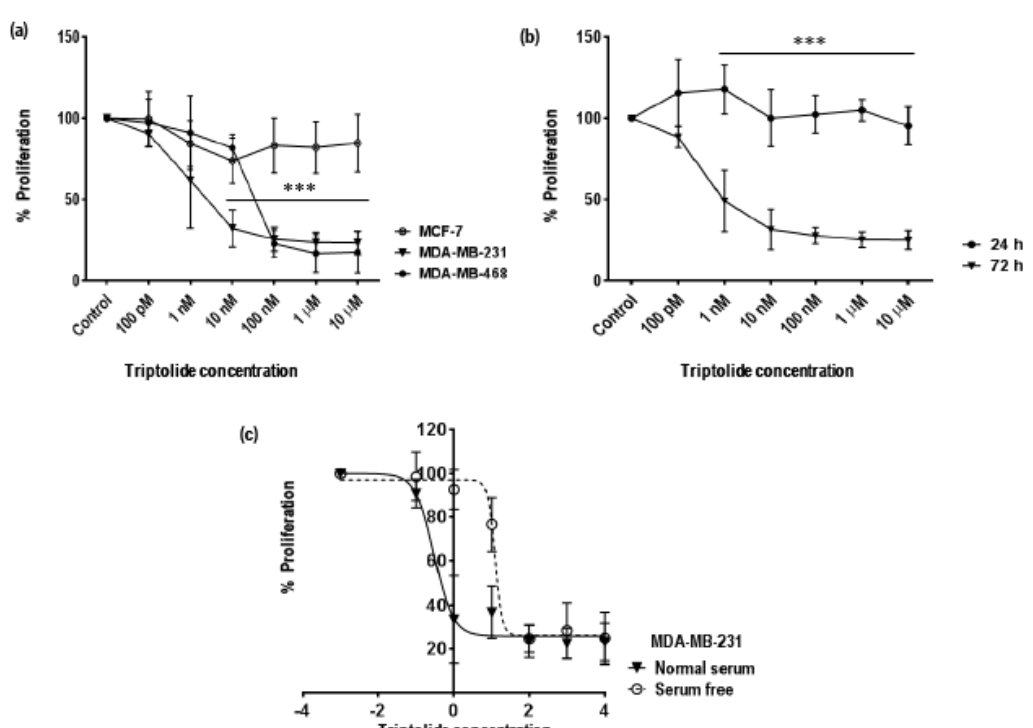
Figure 1. Effect of triptolide on cell proliferation in MDA-MB-231 cells. The line graph illustrates the effect of varying concentration of triptolide (100 pM to 10 µM) on cell proliferation ( a ) in MDA-MB-231, MDA-MB-468, and MCF-7 breast cancer cells after 72 h of triptolide treatment, ( b ) in MDA-MB-231 TNBC cells after 24 h and 72 h of treatment, and ( c ) in MDA-MB-231 cells after 72 h in treatment in the absence/presence of serum in the medium. Triptolide significantly reduced the cell proliferation in MDA-MB-231 cells when compared to MCF-7 cells, indicating that triptolide showed varied growth inhibitory effects in different breast cancer cell lines and the effect on MDA-MB-231 was more pronounced after 72 h of treatment. The presence of serum in the growth media enhanced the growth inhibitory action of triptolide in MDA-MB-231 cells, while serum withdrawal decreased the growth inhibitory effect. The inhibition of cell proliferation was significant between different groups with significance of *** p < 0.0001. MTS assay was used to evaluate the anti-proliferative effect of triptolide. Each graph represents pooled data from at least five experiments. The values are represented as mean ± standard deviation (SD).